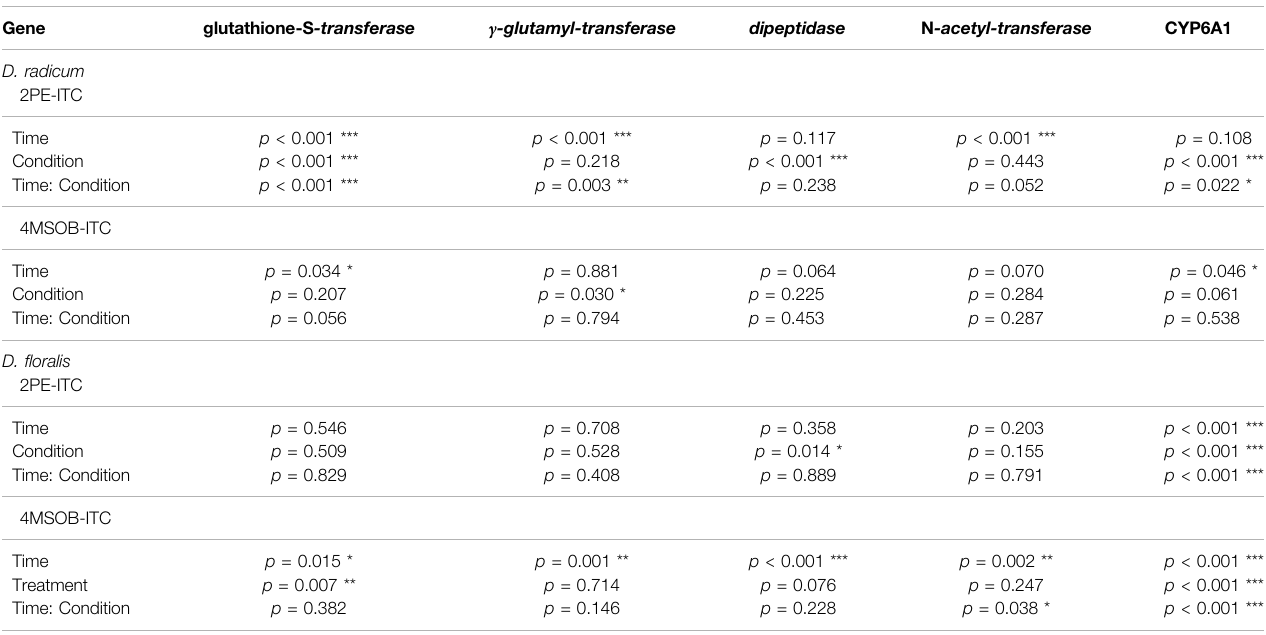
TABLE 3 | Two-way ANOVA and Tukey post-hoc of transcripts in Delia radicum or D. fl oralis larvae treated with different ITCs at different time points (6, 24, 48 h), relative to untreated controls. Each condition and time point wererepresentedby4till 5replicates, depending onthesurvivalofthelarvae.2PE-ITC (2-phenylethylisothiocyanate), 4MSOB-ITC (4-(methylsul fi nyl)butyl